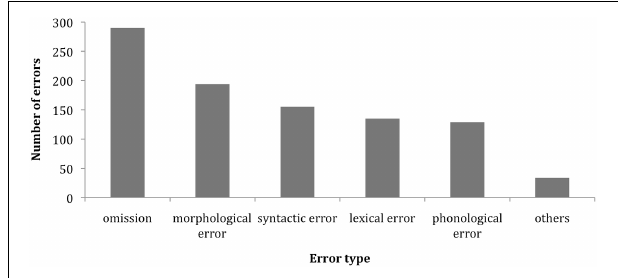
FIGURE 3 | Incidence and relative proportions of error types across 75